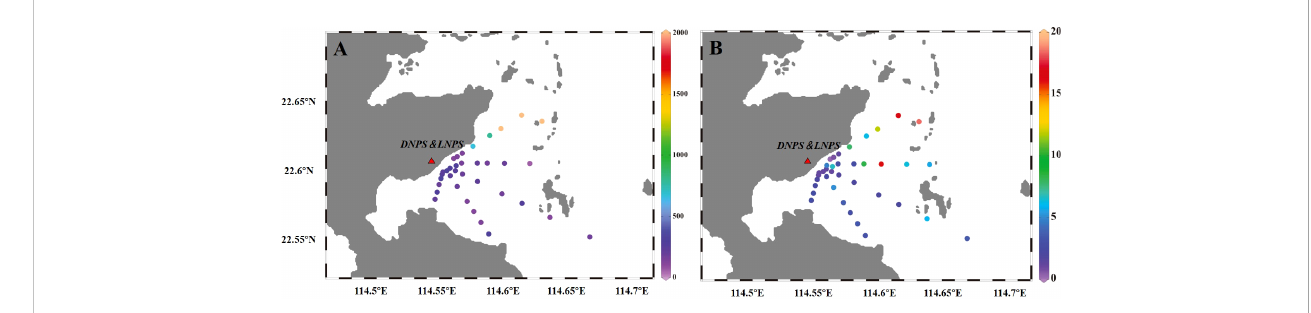
FIGURE 3 Distribution patterns of phytoplankton abundance [ (A) , cells L -1 ] and total chlorophyll a concentration [ (B) , m g L -1 ] in the survey area.